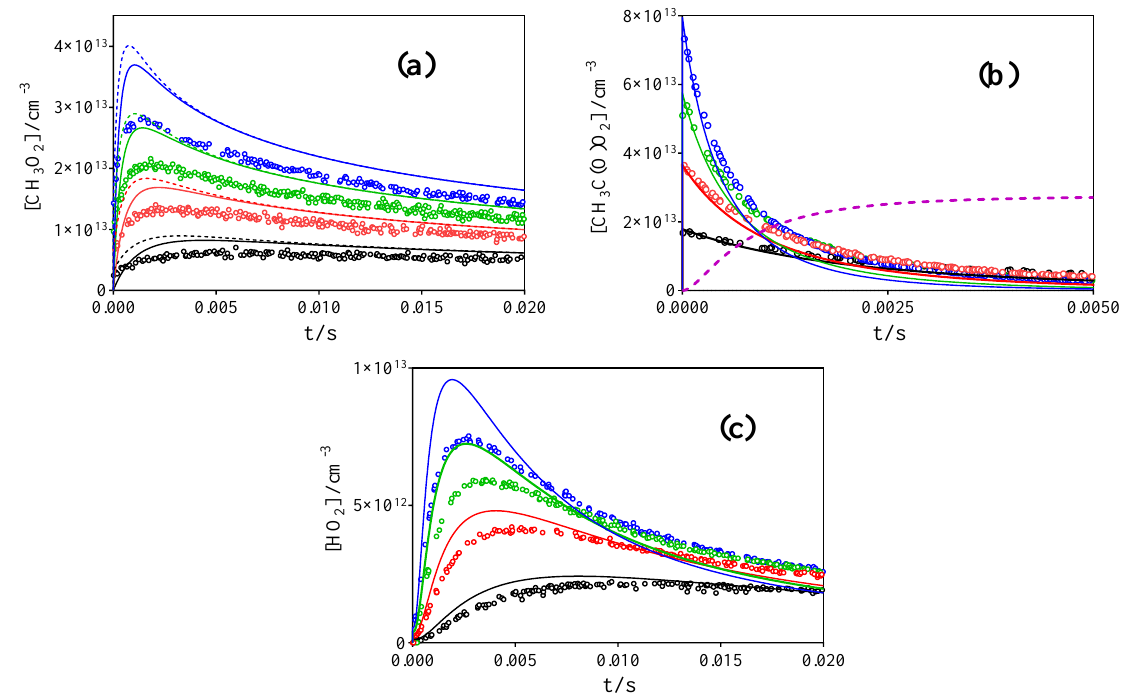
Figure 9. Concentration-time profiles for CH 3 O 2 ( a ), CH 3 C(O)O 2 ( b ) and HO 2 ( c ), obtained following the photolysis of [Cl 2 ] = = 1.6 (blue), 1.17 (green), 0.77 (red) and 0.34 × 10 16 cm − 3 (black) in presence of [CH 3 CHO] = 5.9 × 10 15 cm − 3 at 100 Torr O 2 . Full lines present the model from Table 3, dashed line